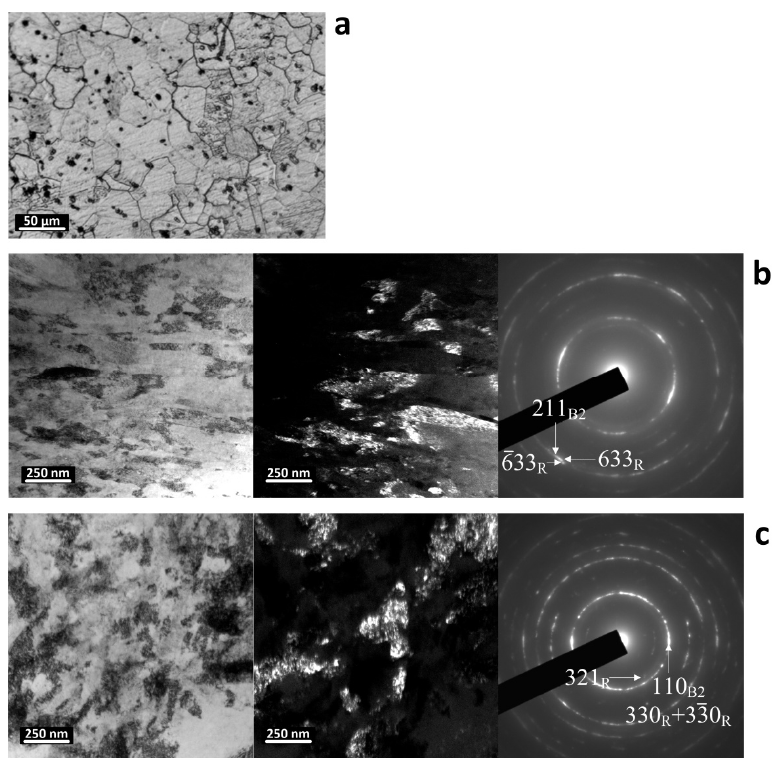
Figure 4. Structure of NiTi alloy after reference treatment, light optical microscopy ( a ), after MS deformation at 350 °C, e = 6.6 ( b ), and 330 °C, e = 9.5 ( c ); both of them involved transmission electron tion at 350 ◦ C, e = 6.6 ( b ), and 330 ◦ C, e = 9.5 ( c ); both of them involved transmission electron microscopy. Left, bright-field images; center, dark-field images; right, selected area electron diffrac- tion patterns.